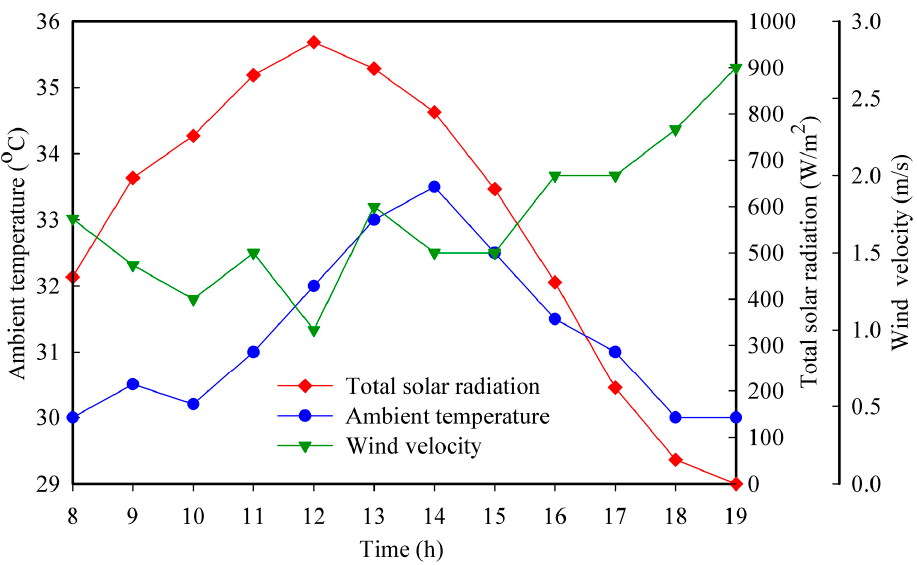
Figure 4. Time dependence: ambient temp, solar radiation, wind velocity.